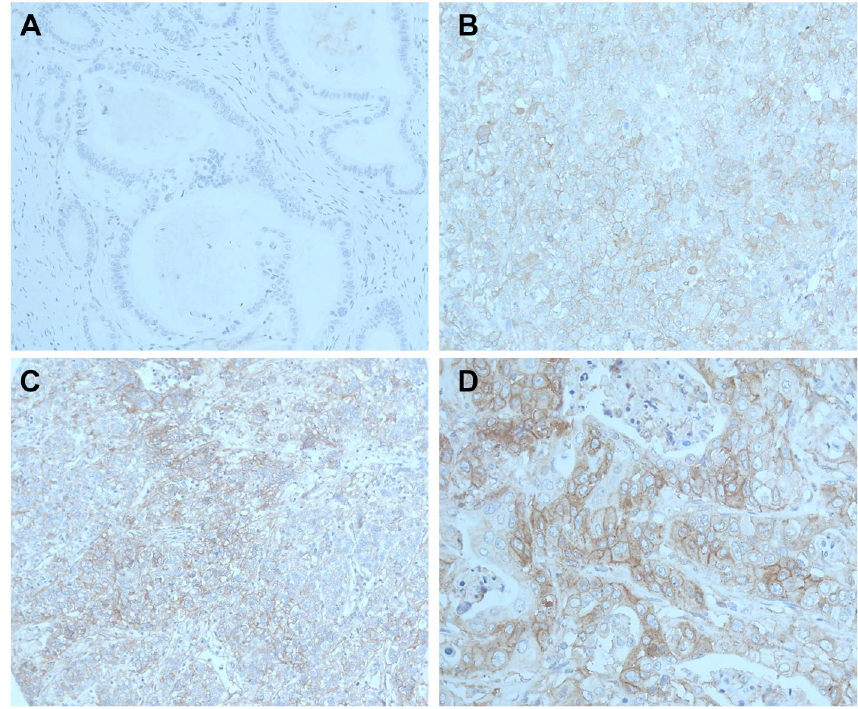
Figure 1. Immunohistochemistry staining for integrin beta1 (ITGB1). Negative tumor sample for ITGB1 ( A ), weak ( B ), moderate ( C ) and strong staining intensity ( D